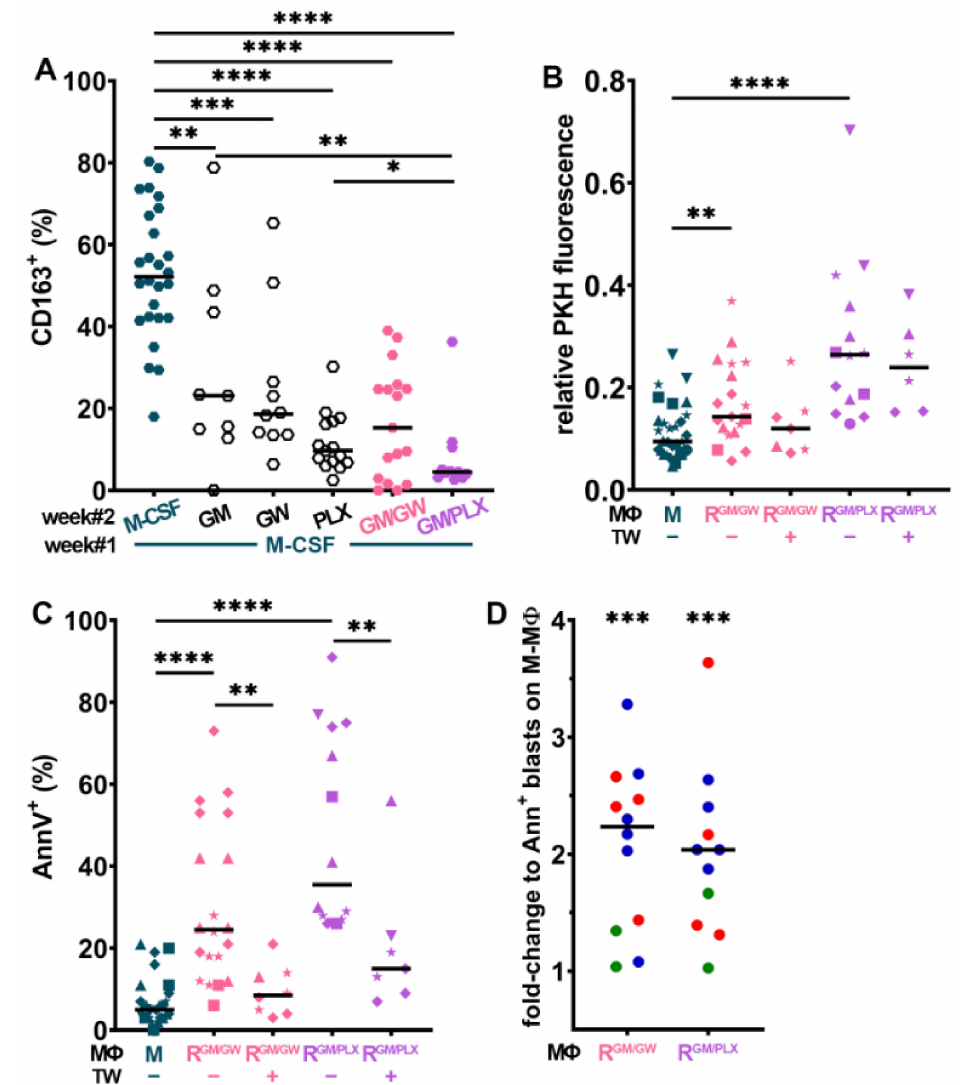
Figure 3. R-M Φ s induce myeloblast apoptosis. ( A ) Expression frequency of CD163 + M Φ s whose culture medium has been supplemented with M-CSF for 2 weeks or switched to reorient- ing medium with GM-CSF (GM) and/or GW2580 (GW) and/or PLX3397 (PLX) for one week, n = 11–26. ( B , C ) PKH-labeled leukemia cell lines were cultured for 4 days on monolayers of M- or R GM/GW - or R GM/PLX -M Φ s +/ − TW and analyzed for proliferation ( B ) and survival ( C ), n = 14–30. (cid:70) = HL-60, (cid:4) = MV-4-11, (cid:78) = NB4, (cid:7) = U937, and (cid:72) = OCI-AML3. ( D ) Primary patient myeloblasts color-coded according to ELN genetic risk were co-cultured for 4 days on mono- layers of M- or R GM/GW - or R GM/PLX -M Φ s and analyzed for survival; AnnV positivity is ex- pressed as fold-change compared to culture on M-M Φ s. n = 11–12. * p < 0.05, ** p < 0.01, *** p < 0.001, and **** p < 0.0001 (using M-W test ( A – C ) or WMP test ( D